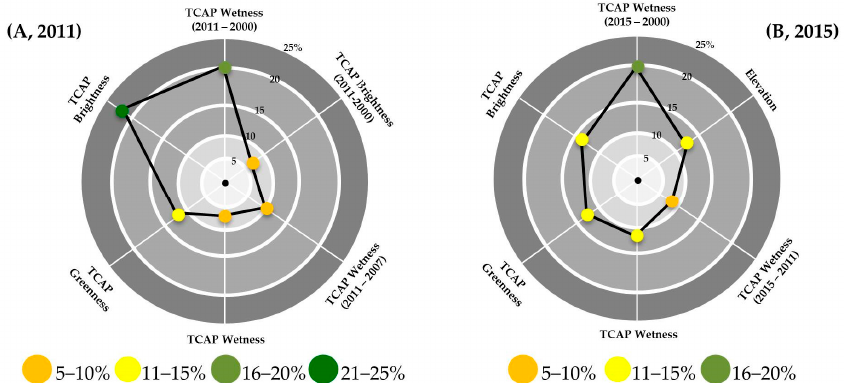
Figure 3. Radar charts displaying the variable importance of predictors retained in the final models for ( A ) 2011 and ( B ) 2015 models.